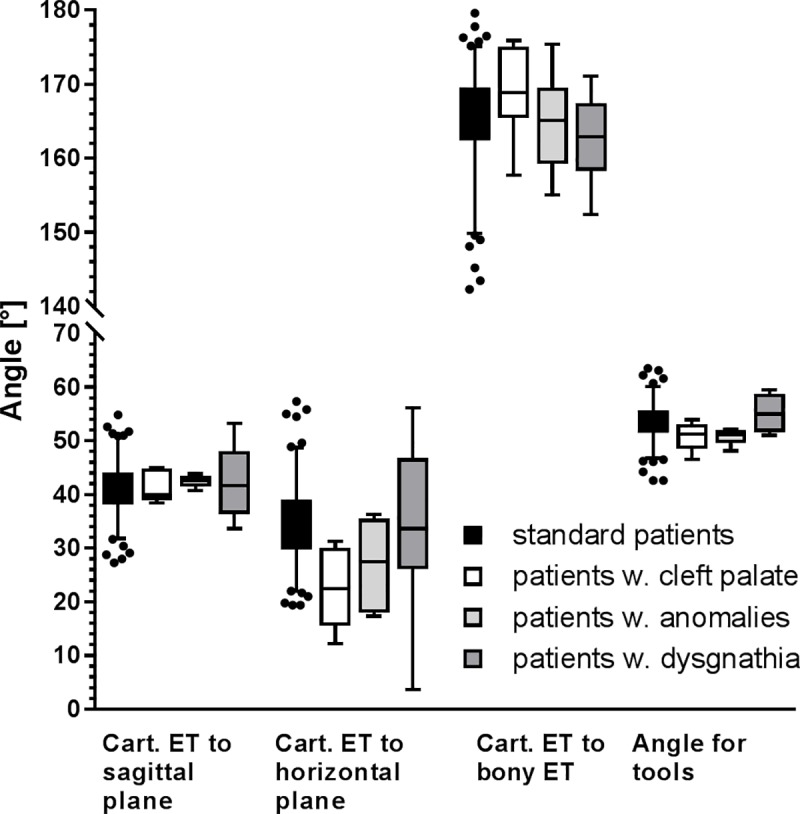
Determined angles of the cartilaginous part of the ET with the sagittal (far left) and horizontal planes (central left) as well the angles between bony and cartilaginous parts (central right) and angles that should be covered by insertion tools (far right). Upper and lower whiskers comprise 95% of values (2.5 to 97.5 percentile) and outliers are indicated. Values for standard patients are presented (black) as well as for cleft palate (white), anomalies (light grey) and dysgnathia (dark grey).